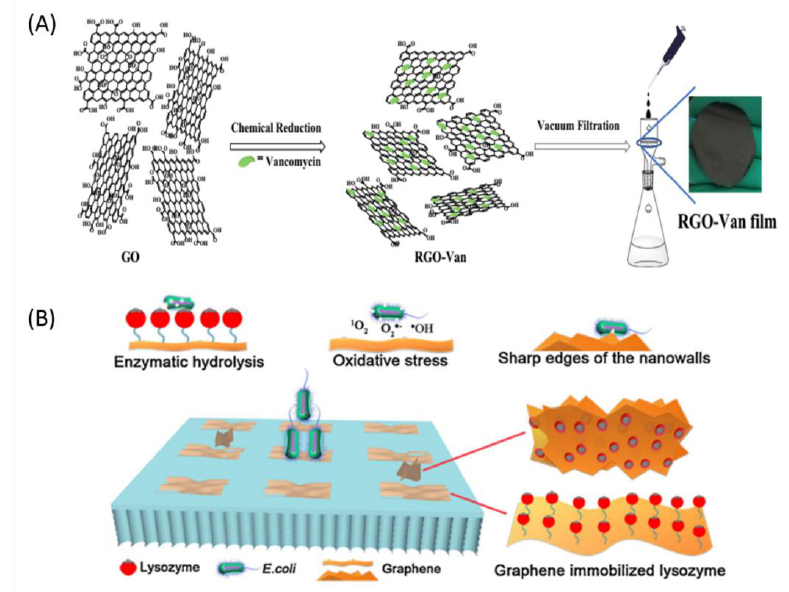
Figure 5. ( A ) Schematic representation for the fabrication of rGO-Van sheets and film. Reproduced from Reference [203], with permission from Elsevier, 2018. ( B ) Immobilization of lysozyme on graphene and illustration of the antibacterial mechanism of the hybrid membrane. Reproduced from Reference [86], with permission from Elsevier, 2015.